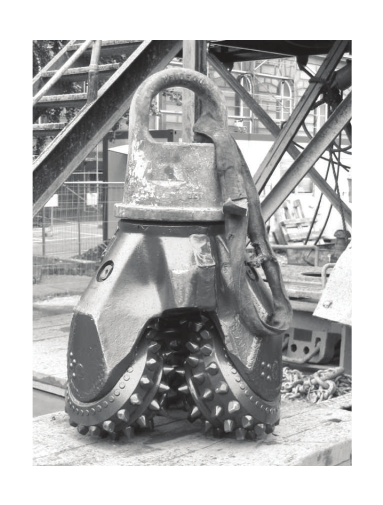
Figure 2: The drill bit.